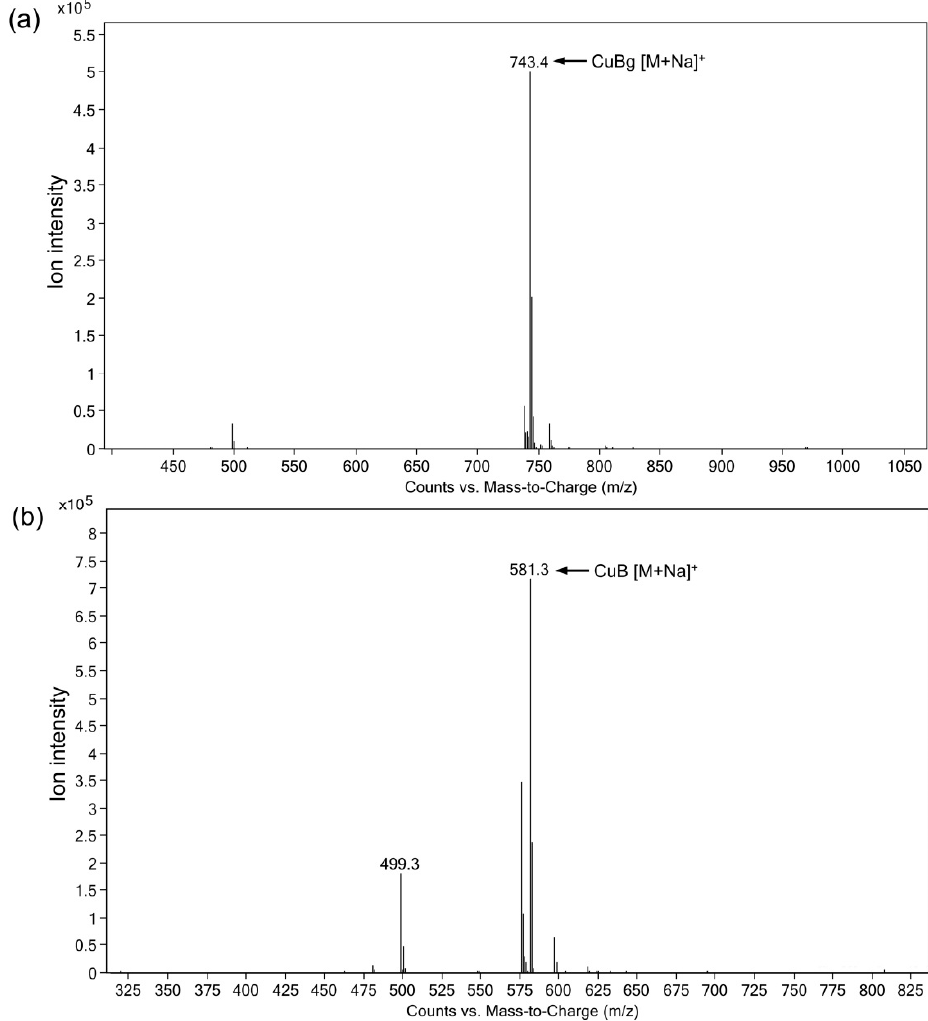
Figure 7. LC–ESI-MS spectra of CuBg and CuB in C. melo pedicel extracts after biotransformation. ( a ) Peak 1 in Figure 6, corresponding to [M + Na] + at m/z 743.4, indicates that the molecular weight of the compound is 720.4 Da (CuBg). ( b ) Peak 2 in Figure 6, corresponding to [M + Na] + at m/z 581.3, indicates that the molecular weight of the compound is 558.3 Da (CuB).